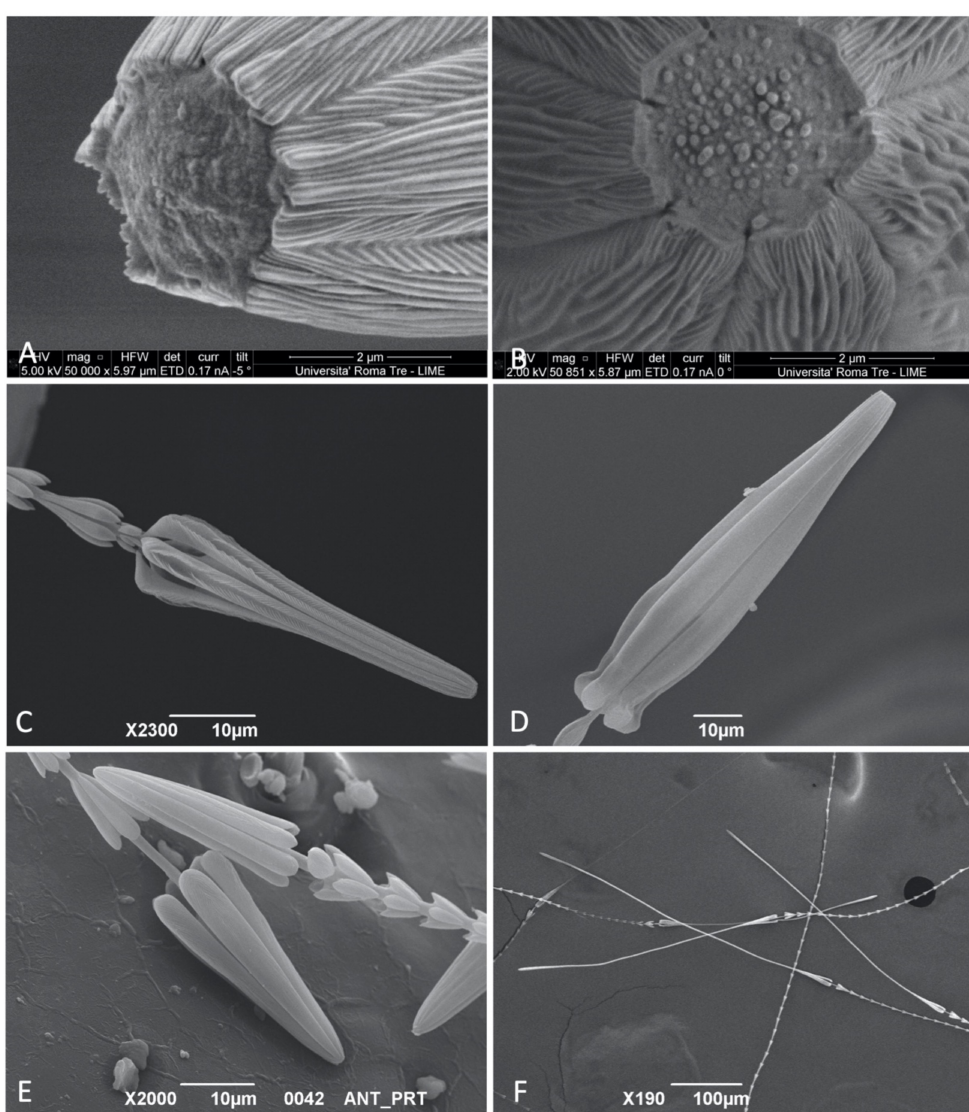
Figure 4. SEM photos of Megatominae larvae: ( A ) Detail of the blunt apex and the circular depression of Trogoderma variabile ; ( B ) Frontal view of the circular depression on the apex of the hastiseta showing the amorphous matrix inside it; ( C ) Head of the hastiseta of Trogoderma sp. 2; ( D ) Head of the hastiseta of Ctesias serra ; ( E ) Head of the hastiseta of Anthrenus sp. 2; ( F ) Head of the hastiseta of Anthrenus picturatus makolskii